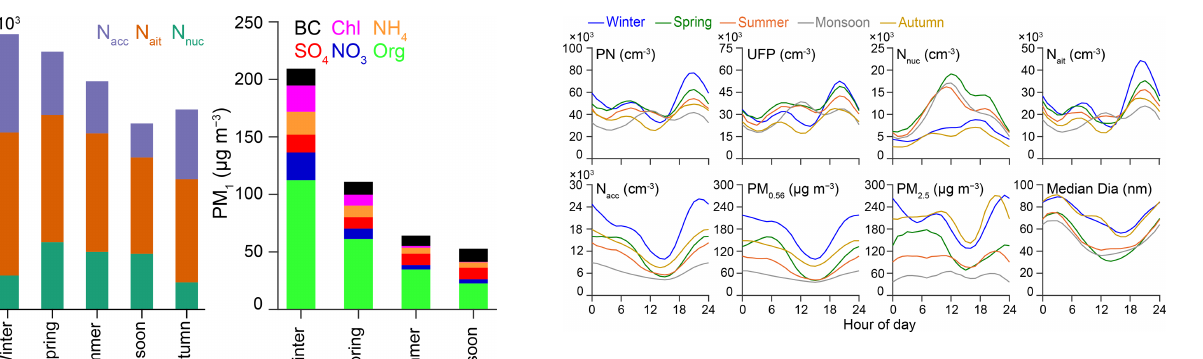
Figure 3. Average diurnal and seasonal variations for PNs, UFPs ( D p < 100nm), N nuc ( D p < 25nm), N ait (25 < D p < 100nm), N acc ( D p > 100nm), and median particle diameter. These averages are based on the observed SMPS data (12 < D p < 560nm). Also included are the average diurnal and seasonal variations of the mass concentrations estimated from the observed SMPS data (PM 0 . 56 ) and the PM 2 . 5 concentrations from a regulatory monitor (Delhi Pol- lution Control Committee – DPCC; Rama Krishna Puram, 3km from our site), which were accessed from the OpenAQ Platform (http://openaq.org, last access: 1 August